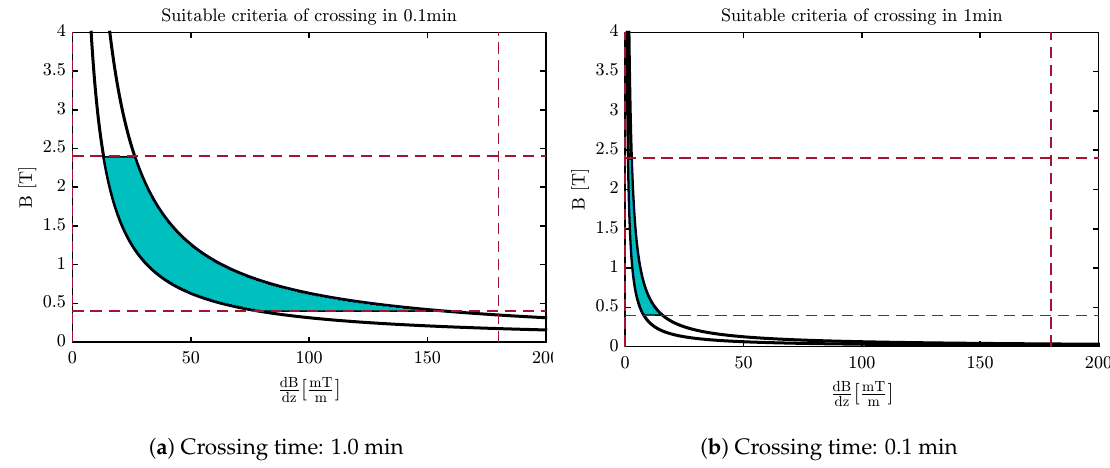
Figure 11. The desired area for selecting the magnetic field and magnetic gradients of the end-capped